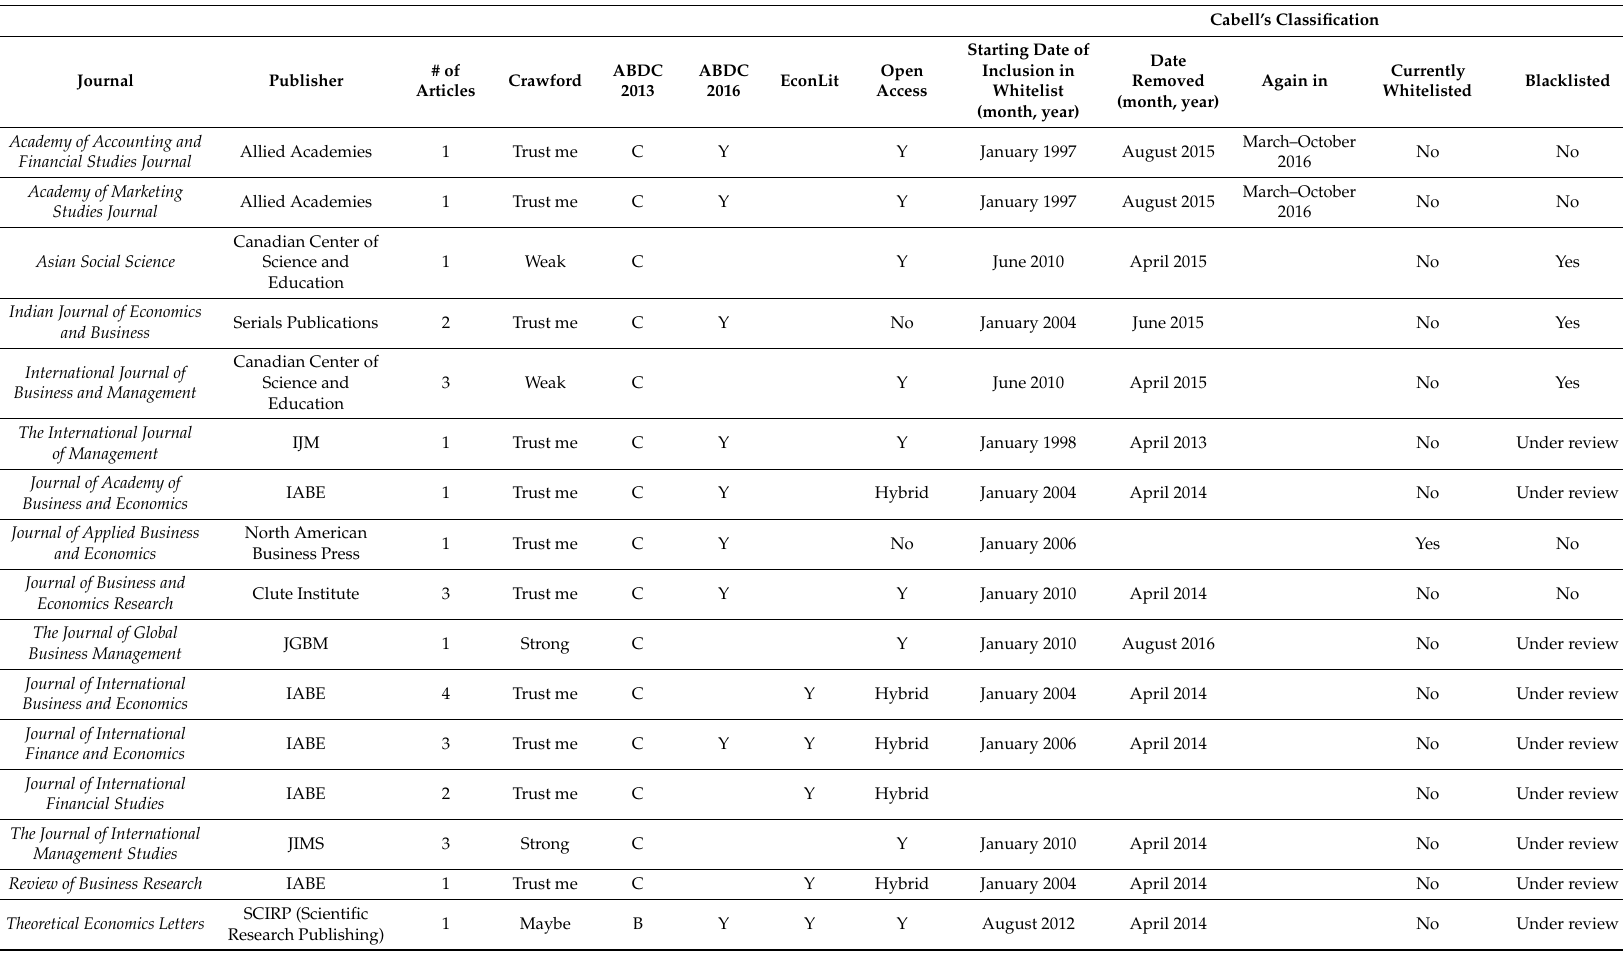
Table 2. Publications of research faculty members in Beall’s 2016 list and ranked in the 2013 ABDC